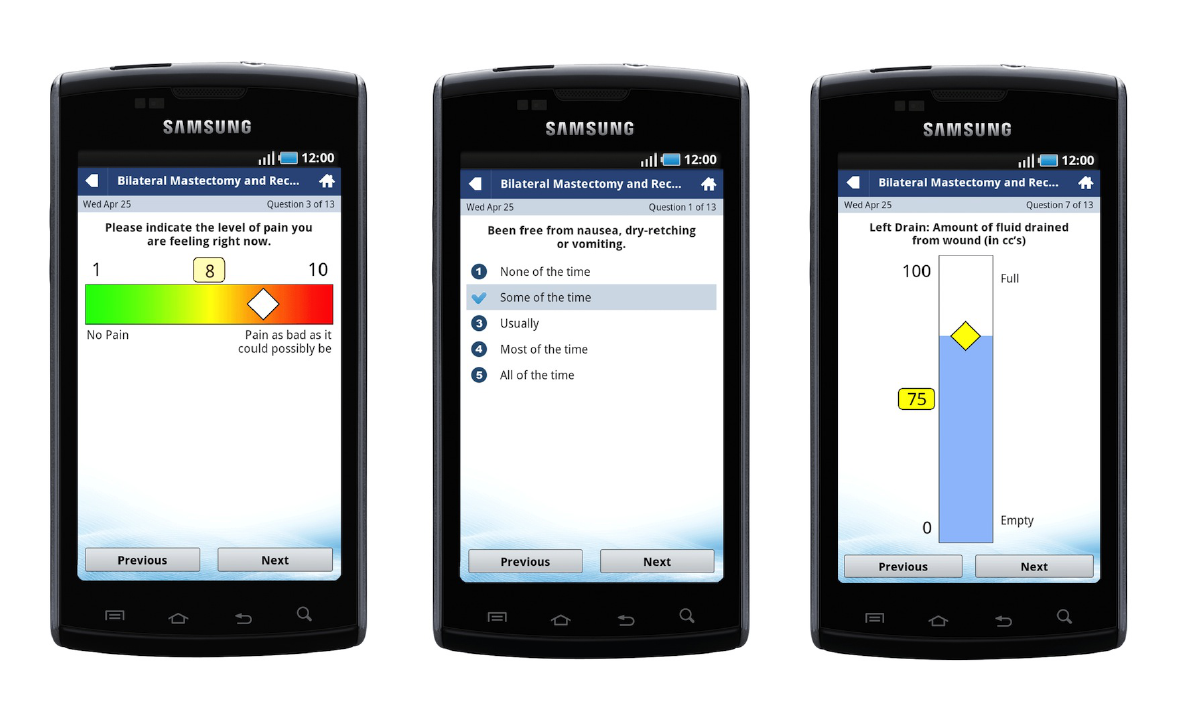
Figure 1. Examples of the touch screen interface of the patient portal, including the visual analogue pain scale, an example of the QoR 9 question on postoperative nausea, and the visual analogue scale for fluid in the postoperative surgical